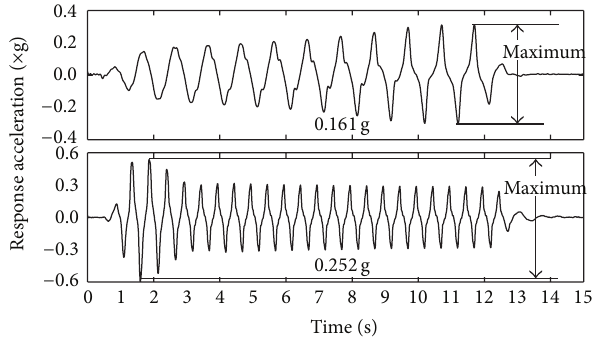
Figure 7: At 0.097 g loading acceleration.